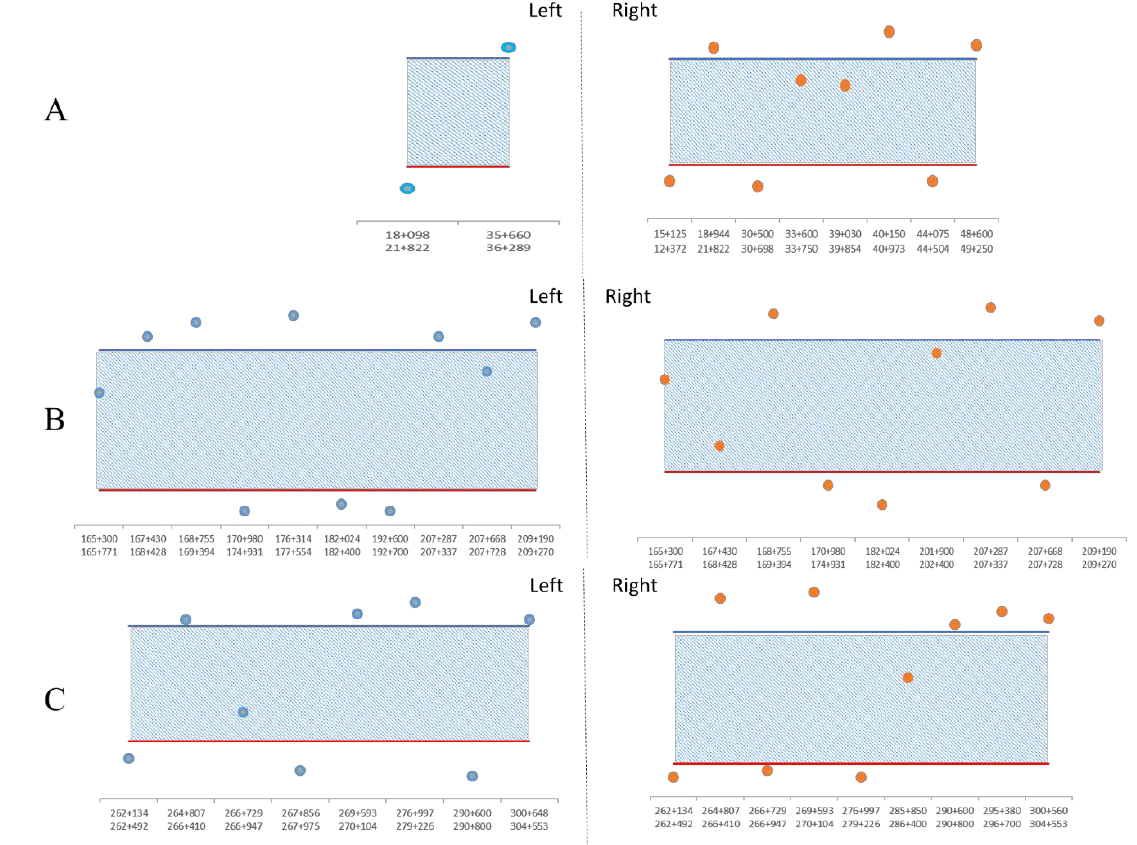
Figure 9. Simulated flow rate results.